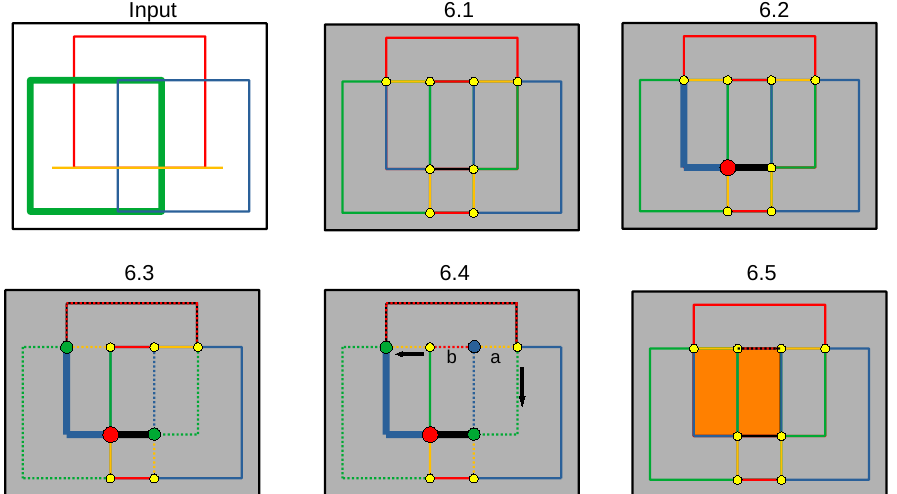
Figure 4. Illustration of Algorithm 2, Step 6 of Algorithm 1. The input of Algorithm 1 is shown in the top right (5 segment complexes). The result of Steps 1–5 of Algorithm 1 is shown in 6.1 (patches are coloured, seams are yellow dots). There is also one triangulated grey surface already found, bounded by the black segment complex that did not intersect any of the other coloured segment complexes. Two patches (thick blue and black line) are connected through one seam (red dot) in 6.2. The goal is to stitch a patchwork with those two patches that forms a valid B-Rep. The idea is to follow the connected patches (dotted lines) on the green seams (see 6.3). One patch is ignored (black red dotted line). It was rejected in a former iteration. All yellow seams have to be checked in 6.4. Starting with the blue seam, two options are available (patch a in orange and patch b in red). Taking patch a first leads to an invalid loop since it maps to the same green seam of the black starting patch where the blue seam is connected to. This loop is ignored. Taking patch b leads to a valid loop since it maps to the green seam of the blue starting patch where the blue seam is not mapped to. The orange square can be triangulated and checked against any one dimensional intersection, which would indicate that the found surface is not a distinct surface in 6.5. Patch b is added to the list of patches which closed some invalid loop to be ignored when restarting at Step